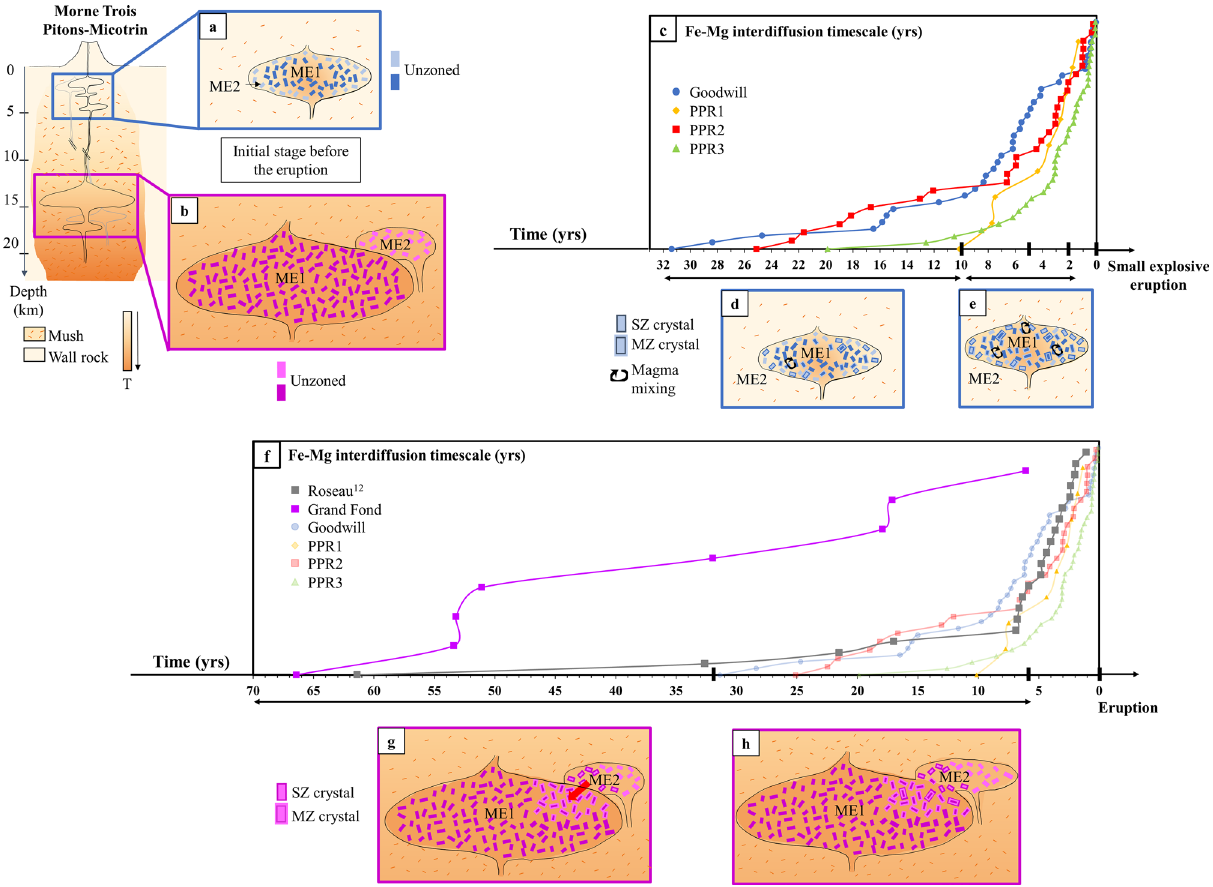
Figure 7. Simplified view of the storage areas and of the pre-eruptive dynamics of the magmas in the magmatic mush for Morne Trois Pitons-Micotrin. Models based on opx compositions and interdiffusion timescales modelling for the small explosive eruptions and Grand Fond. The different magma environments recorded are represented by magma lenses at different depths in a transcrustal system. This schematization agrees with the vision of the magmatic mush showing magma lenses stored at different depths 6 . On top: model of the whole crust with a deep reservoir feeding the large explosive eruptions and a shallower one feeding the small explosive eruptions 38,39 . ( a , b ) initial stages for small explosive eruptions (Goodwill, PPR1-3) and voluminous pumiceous eruption of Grand Fond; c : rank ordering of the interdiffusion timescales modelled in the opx of Goodwill, PPR1-3 (Fig. 5; Supplementary Table S3). Each curve in ( c ) can be divided into three gradients (underlined by black arrows): a shallow one (from 32 to 10 years), a steep one (from ~ 10 to 2–3 years), together with that of a pre-eruptive region (timescales from 0 to 2-years, vertical arrow). A steep gradient can indicate a rapid processing whereas a shallow gradient, a much slower processing. ( d , e ) evolution of the magmas prior to the small explosive eruptions with vigorous magma mixing in a temperature-zoned reservoir, with ME2 being the wall and ME1 the center of the reservoir, in the different periods of time underlined in ( c ); ( f ) rank ordering of the interdiffusion timescales modelled in Grand Fond and Roseau 12 , large explosive eruptions from Morne Trois-Pitons Micotrin volcano compared to the small explosive eruptions (Fig. 5; Supplementary Table S3). In ( f ), for Grand Fond, one gradient can be identified (from 66 to 5 years). For Roseau, two gradients can be identified: a shallow one (from 60 to 7 years) and a steeper one from 7 to 1 year before the eruption. ( g , h ) evolution of the magmas prior to the large explosive eruption with magma mixing following the period of times shown in ( f ). T: temperature; black arrow: magma mixing. SZ: single-zoned opx and MZ: multiple-zoned opx. This Figure has been drawn using Microsoft Office suite 2019 Version 1808 (https:// www. micro soft. com/ fr- fr/ micro soft-